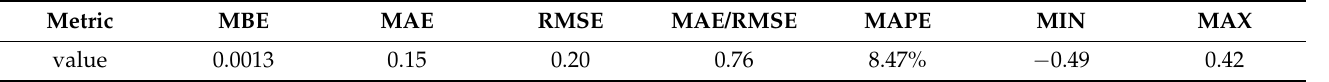
Table 9. Accuracy metrics to assess the goodness of fit of the RK